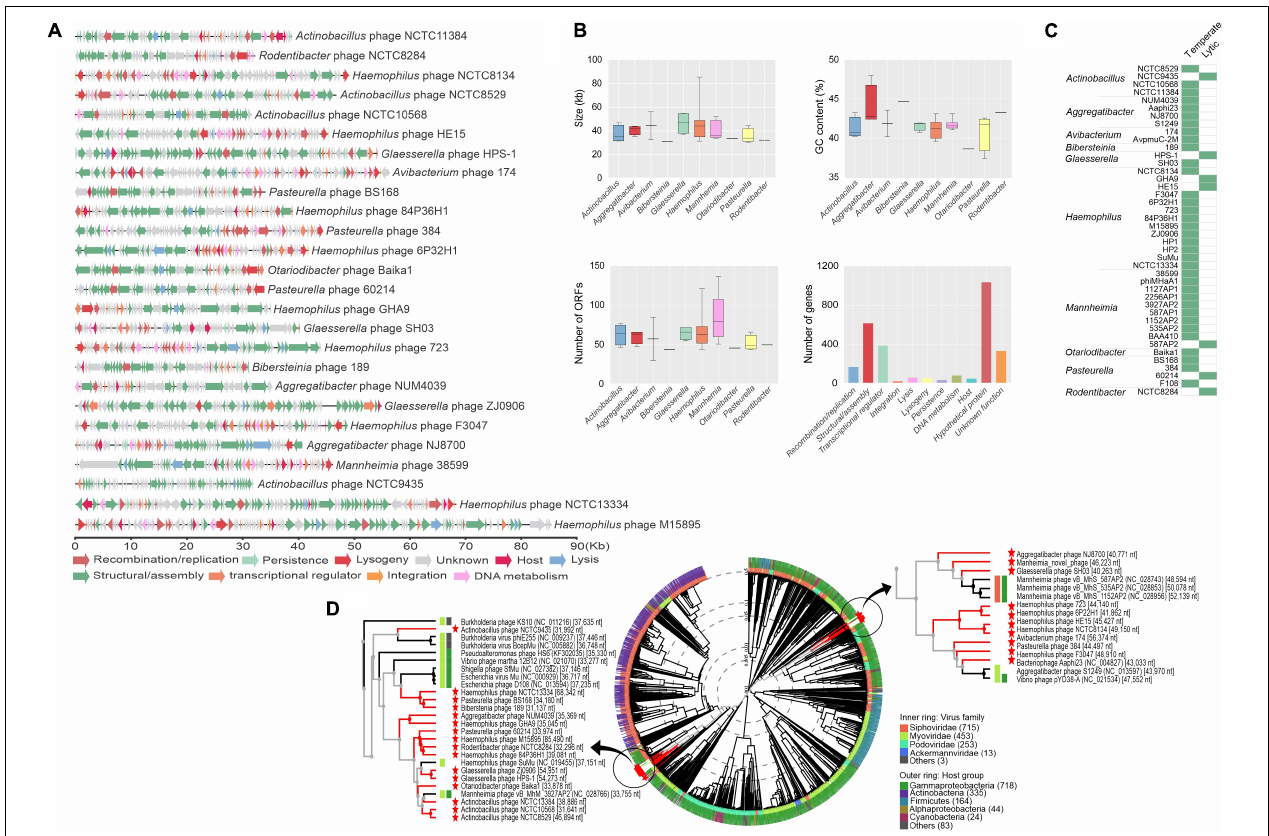
FIGURE 3 | The diversity of prophage elements integrated into Pasteurellaceae genomes. (A) Representation of novel prophage elements found integrated into Pasteurellaceae genomes. Prophage size is indicated in the scale bar (in kilobases) and ORF function is represented by arrows colored below the figure. (B) General overview of complete and novel prophages grouped by genus according to phage size (top-left graph), GC content (top-right graph), ORF content (bottom-left graph), and gene function (bottom-right graph). (C) Lifestyle classification (temperate or lytic) of complete and novel prophages are shown for all of the prophages in this study. (D) Phylogenomic tree analysis of novel prophages and references phages for Pasteurellaceae generated on the VipTree website. Colored rings show the families of viruses (inner rings) and host groups (outer rings). The length of the branch is log-scaled. The red stars represent the novel prophages found in this